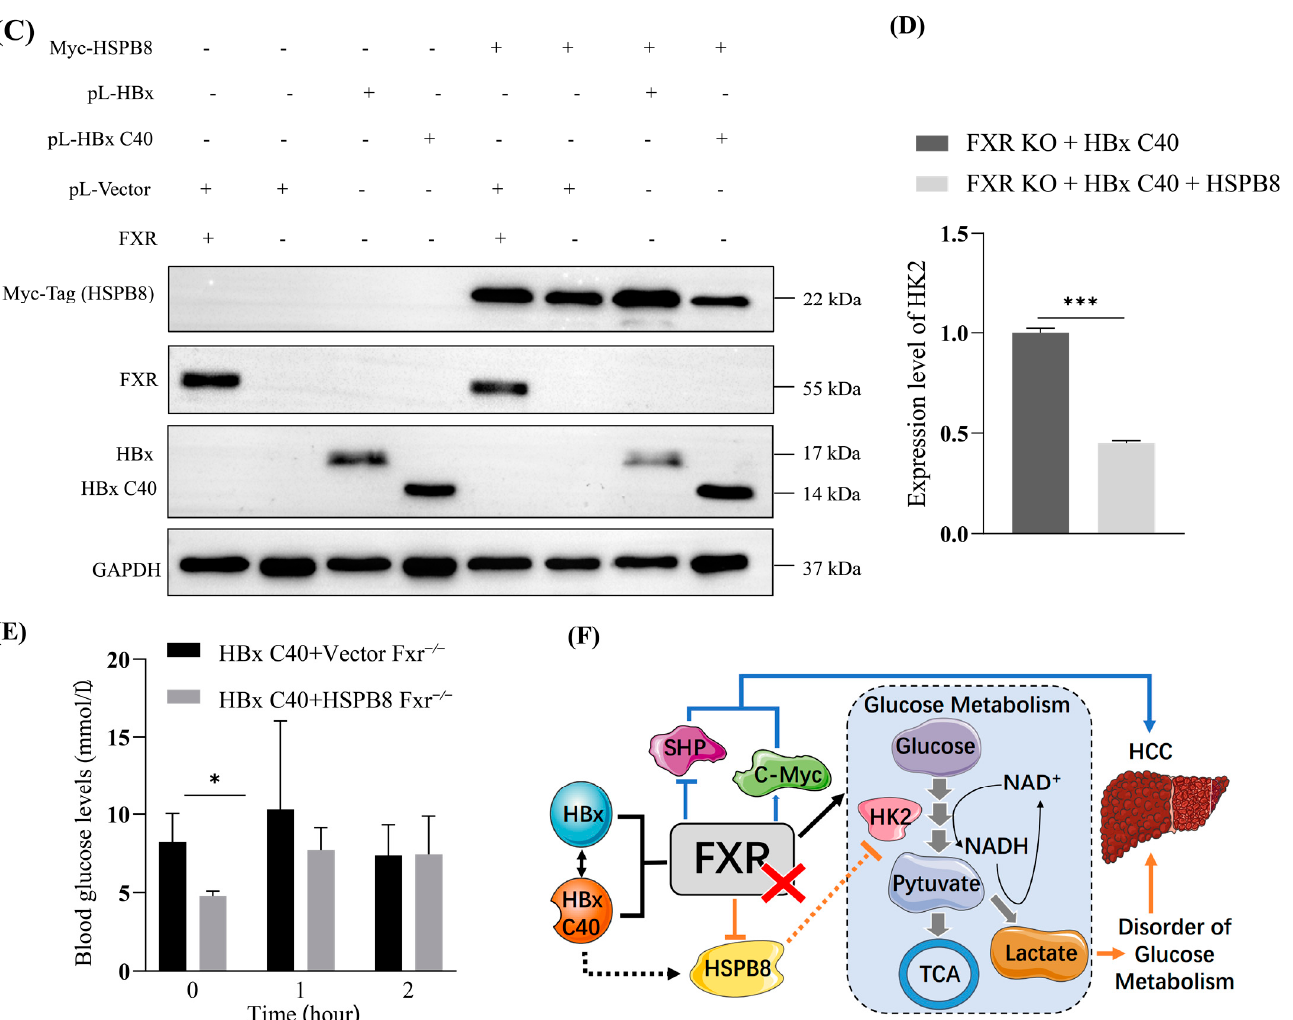
Figure 7. HBx/HBx C40-HSPB8-HK2-glucose metabolism axis in FXR-deficient HCC. ( A , B ) Differentially HSPB8 expression in cells and transient mouse models. ( C ) The overexpression of HSPB8 protein was detected by western blotting. ( D ) The mRNA expression of HK2 in HSPB8 + HBx C40 + FXR KO, HBx C40 + FXR KO, and HBx C40 + FXR KO Hep3B cells were detected by qRT-PCR. ( E ) Fasting blood glucose, blood glucose 1 h after intraperitoneal injection of high glucose and 2-h postprandial blood glucose in transient mouse models. ( F ) Schematic diagram illustrating the induction of hepatocarcinogenesis, by HBx C40 expression combined with FXR deficiency, through inhibiting the regulation of HSPB8-HK2-glucose metabolism, including the gluconeogenesis and glycolysis axis, in the liver. * p < 0.05, ** p < 0.01, *** p <